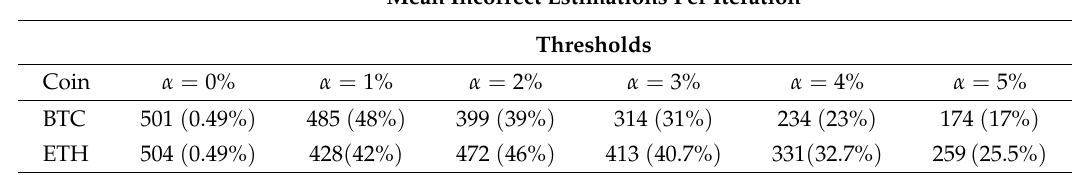
Table 3. Mean incorrect estimations out of the total T = 1017 observations, per iteration of the BTC and ETH binary series. Increasing the magnitude of minimum returns the average number of misestimations decreases. This shows that the covariate set has explanatory power on defining the probability of larger returns. In parenthesis we report the error rate.